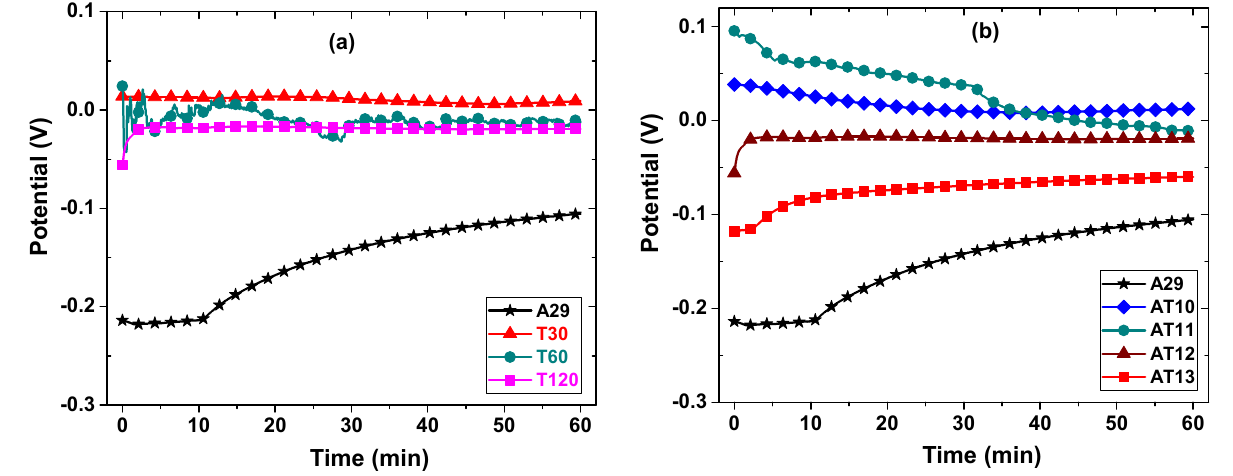
Figure 7. ( a ) Open circuit potentials showing the effect of ( a ) solutionizing duration and ( b ) solutionizing temperature on the corrosion behavior of N08029 after 1 hr immersion in 3.5% NaCl aerated solution.